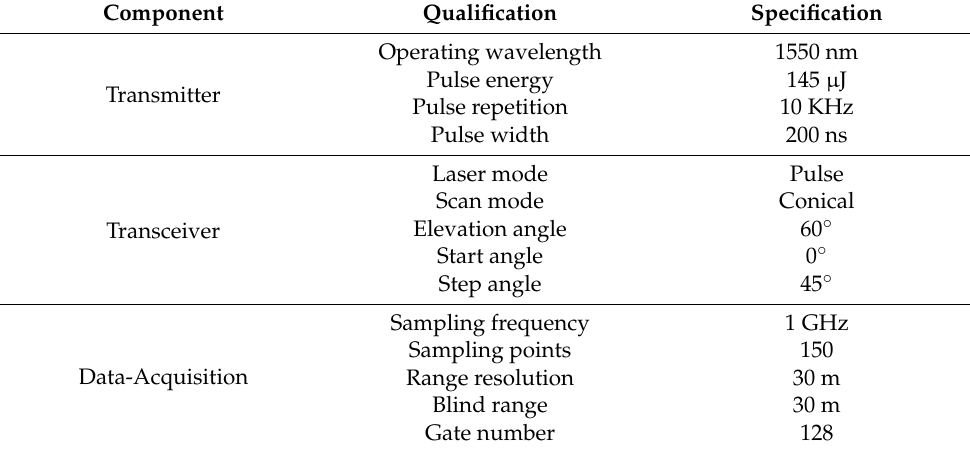
Table 1. Wind profile radar system parameters.